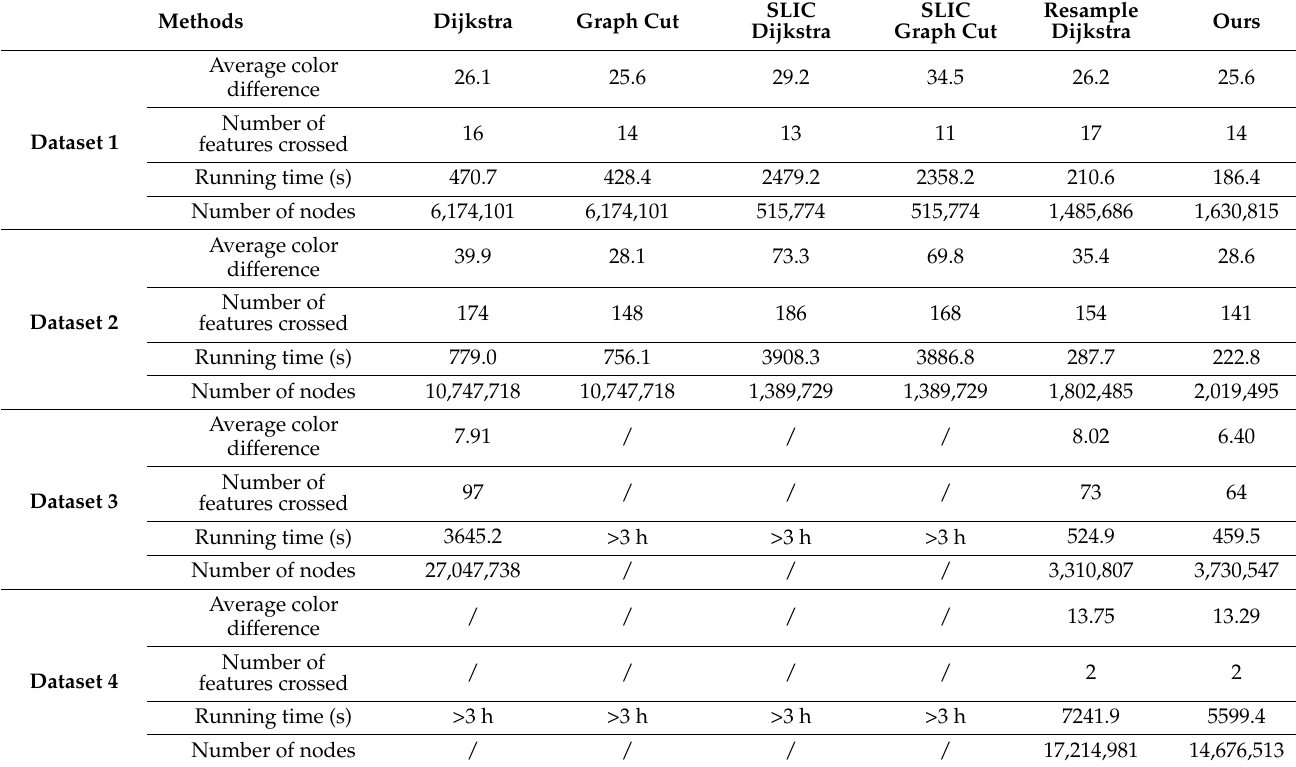
Table 3. Statistics obtained by applying six different methods to four data